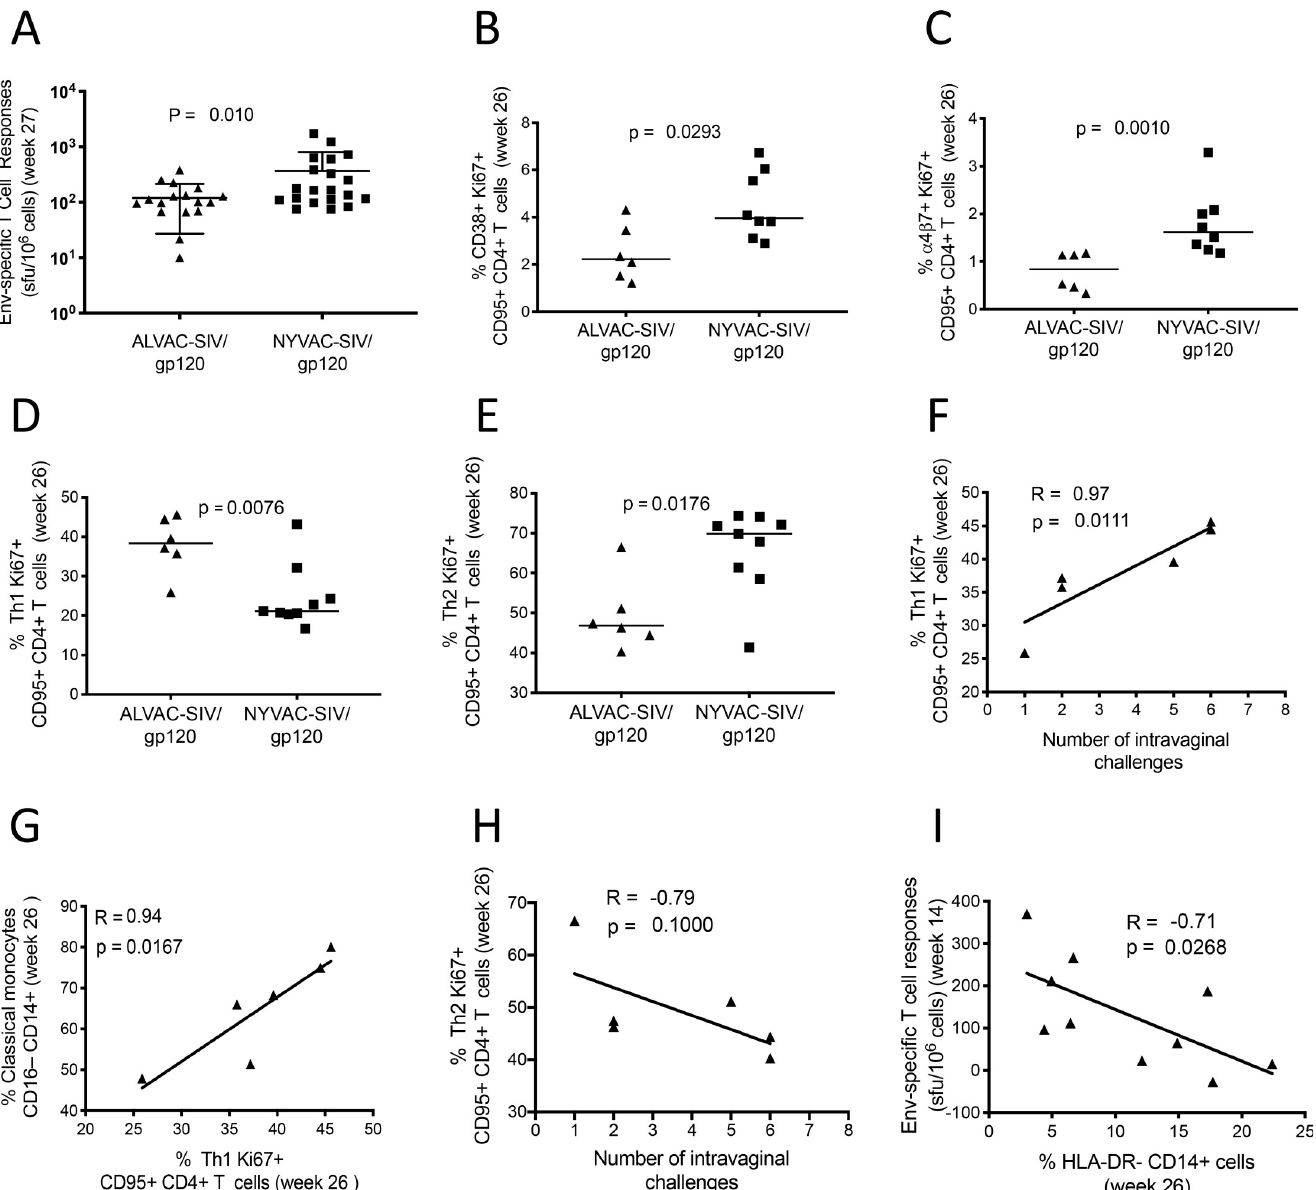
Fig 4. CD4 + T cell subsets. (A) T cell ELISpot in the vaccinated group at 3 weeks after the last immunization (week 27). CD4 + T cells were measured in 6 ALVAC- vaccinated and 8 NYVAC-vaccinated macaques. (B) Percentage of vaccine-induced (Ki67) CD38 + CD4 + T cells at week 26. (C) Percentage of KI67 + α 4 β 7 + CD4 + T cells at week 26. (D) Frequency of Th1 (CXCR3 + CCR6 – ) and (E) Th2 (CXCR3 – CCR6 – ) CD4 + T cells at week 26 (horizontal line: median). (F) Direct associations between the levels of ALVAC-SIV/gp120 induced Th1 cells at week 26 and the number of challenges to infection or (G) to the frequency of classical monocytes in blood at week 26. (H) Inverse correlation of Th2 cells measured at week 26 and time of SIV mac251 acquisition. (I) Correlation of CD14 + HLA-DR - (MDSCs) measured at week 14 and the level of anti-envelope ELISpot responses in blood at week 14.